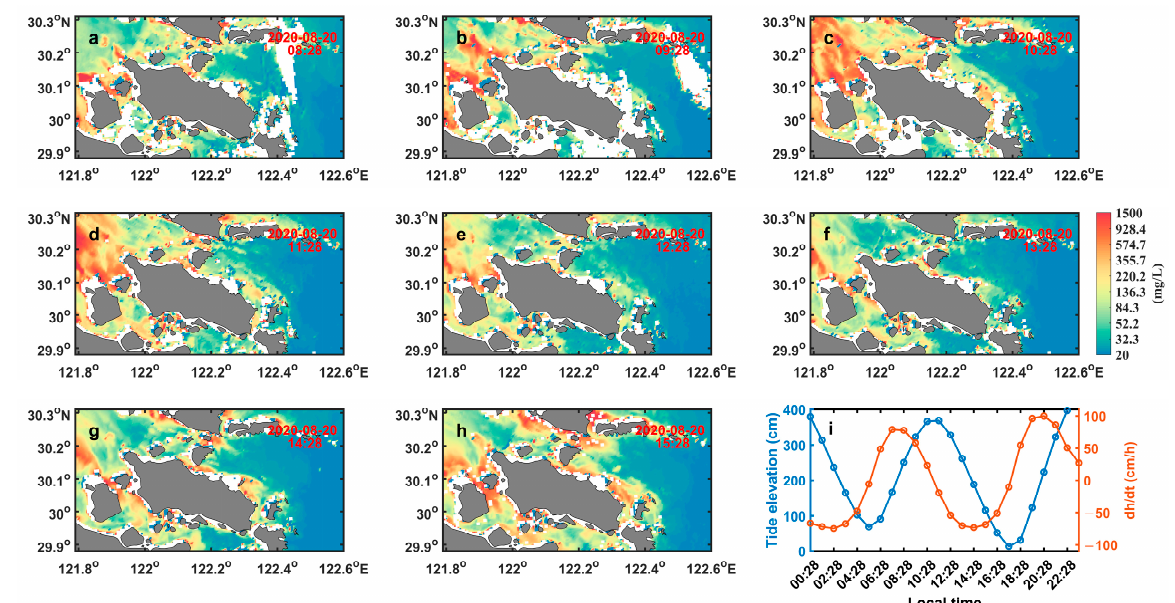
Figure 12. Same as Figure 10 but for the spring tide on 20 August 2020.